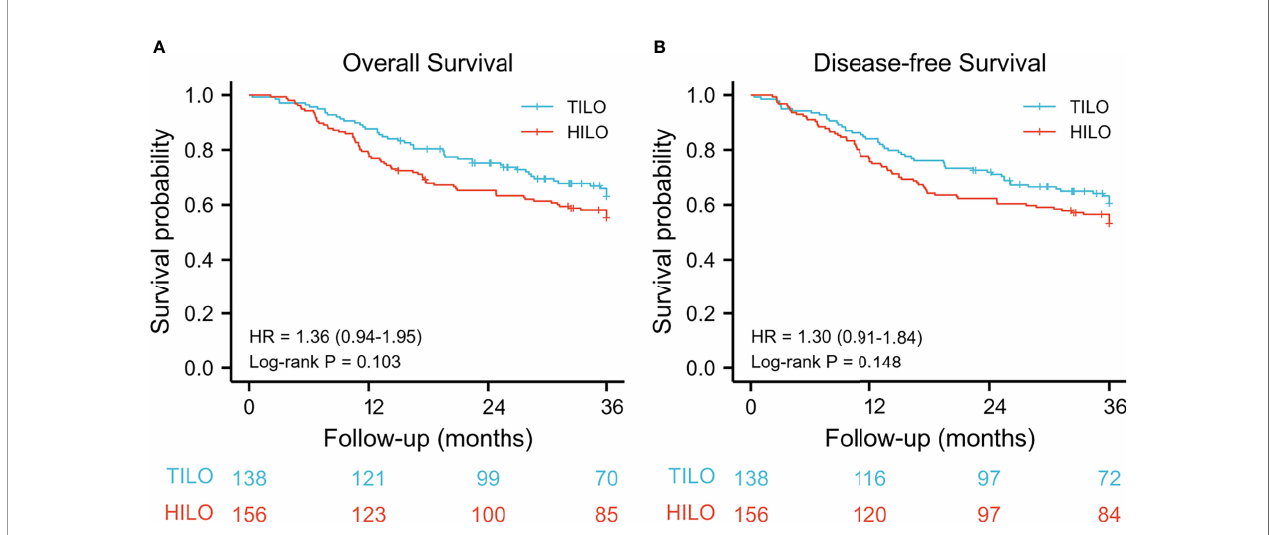
FIGURE 2 | Kaplan – Meier curves for unmatched patients between totally minimally invasive oesophagectomy (TILO) group and hybrid minimally invasive oesophagectomy (HILO) group. (A) overall survival, (B) disease-free survival.